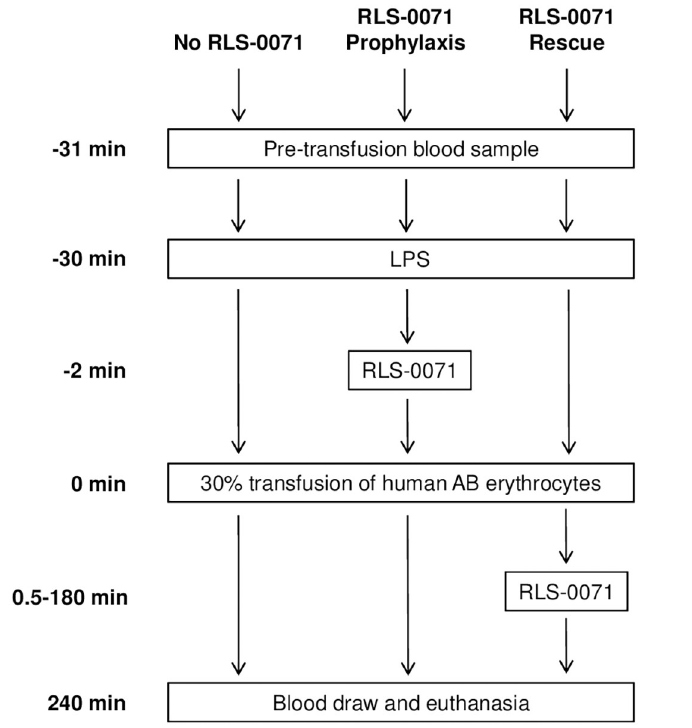
Fig 1. Experimental design and study